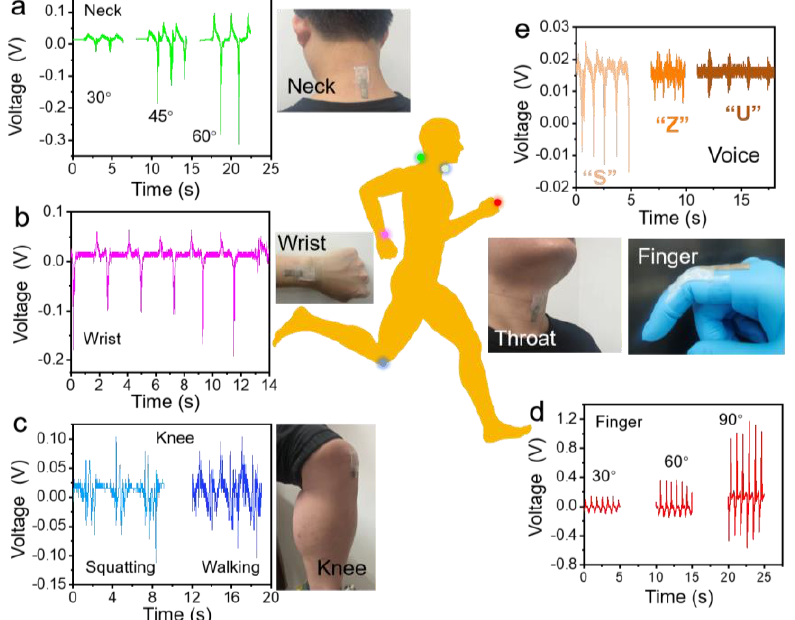
Figure 7. The output voltage and photos of different human motions using the double-side EPS with PVDFnfs sensors attached to the corresponding parts of a volunteer: ( a ) the neck (bent at 30 ◦ , 45 ◦ , 60 ◦ ), ( b ) the wrist, ( c ) the knee while walking, ( d ) the index finger (bent at 30 ◦ , 60 ◦ , 90 ◦ ), and ( e ) the throat (four times pronouncing “S”, “Z”, and